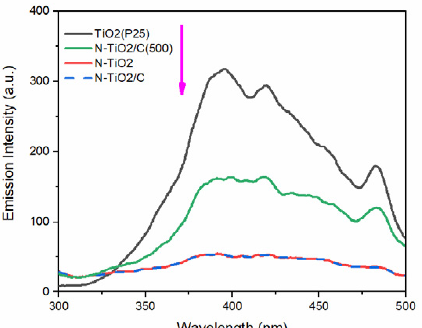
Fig. 9. Photoluminescence spectra of TiO